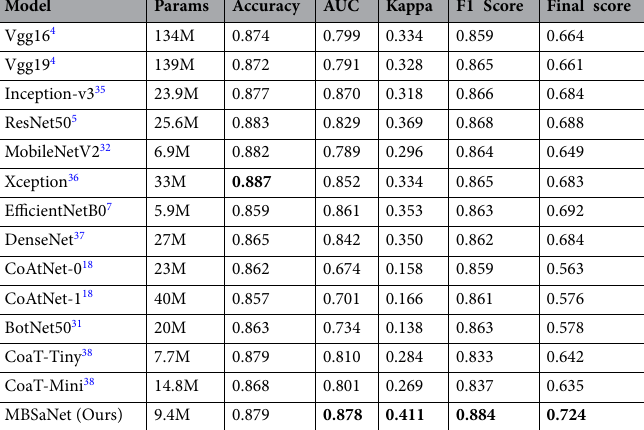
Table 3. Comparison with some CNN networks and hybrid models on the on-site test set. Significant values are in bold.